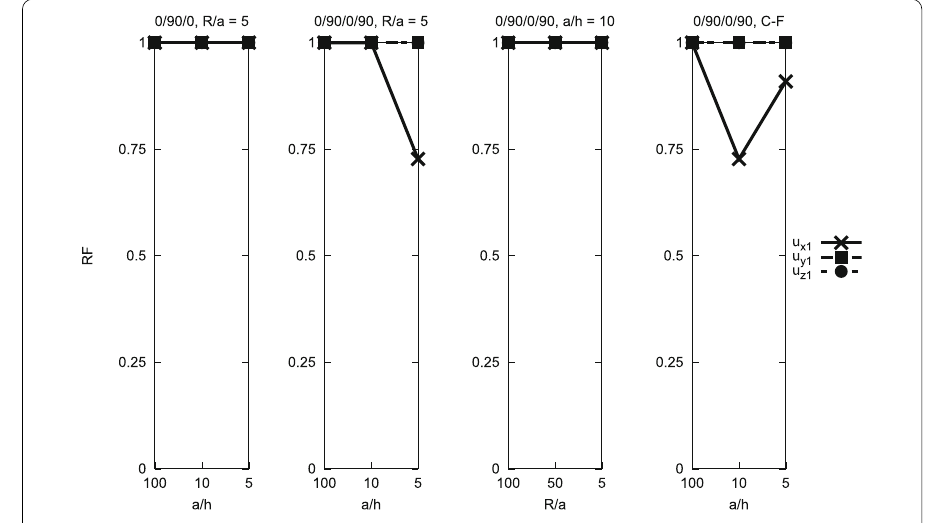
Fig. 11 RF for zeroth-order displacement variables